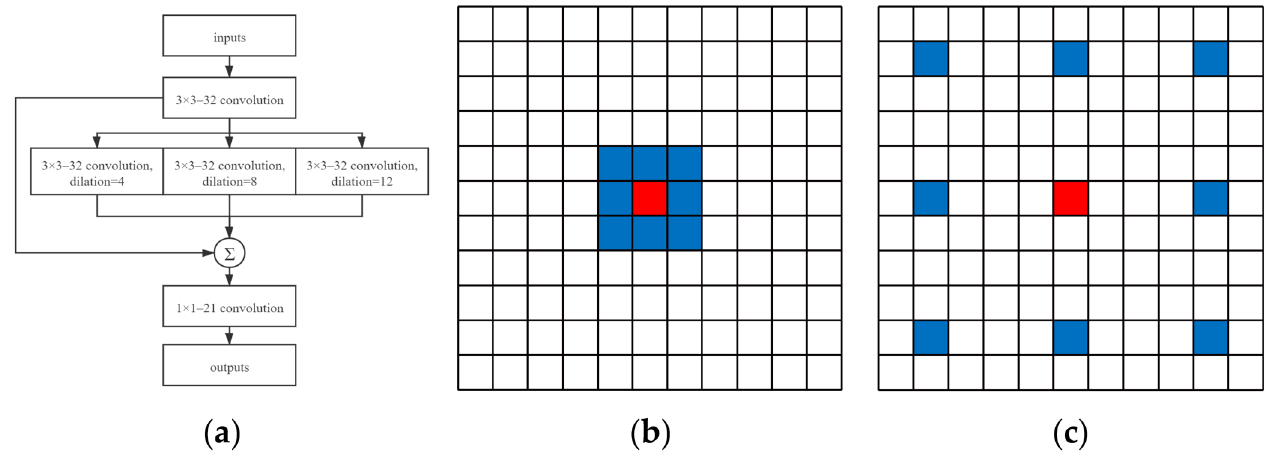
Figure 5. SEM and different convolution kernels: ( a ) the details of SEM; ( b ) the standard 3 × 3 convolution kernel; ( c ) the 3 × 3 dilated convolution kernel with dilation of 4.